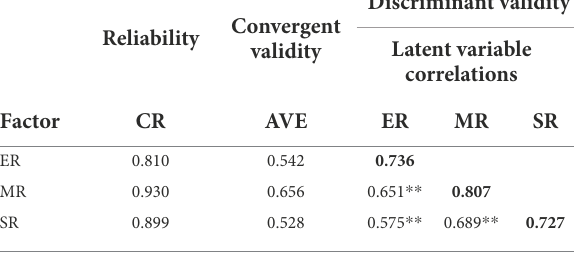
TABLE 2 Overall reliability and validity analysis of the measurement model.